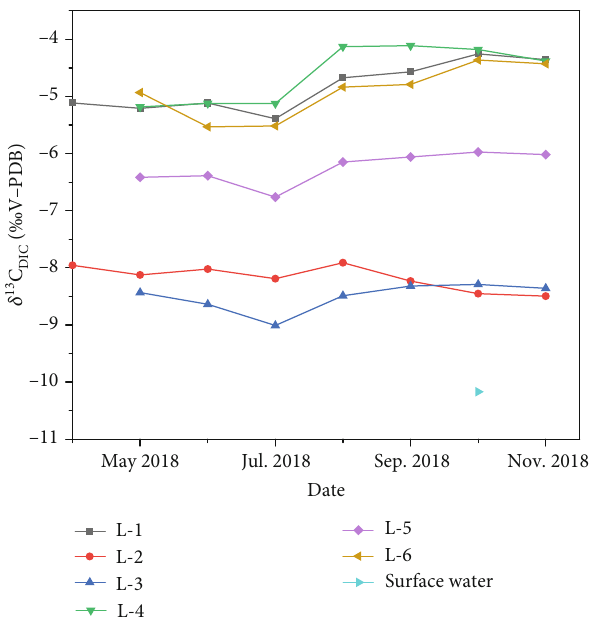
Figure 7: Variation of dissolved inorganic carbon in production water with time.